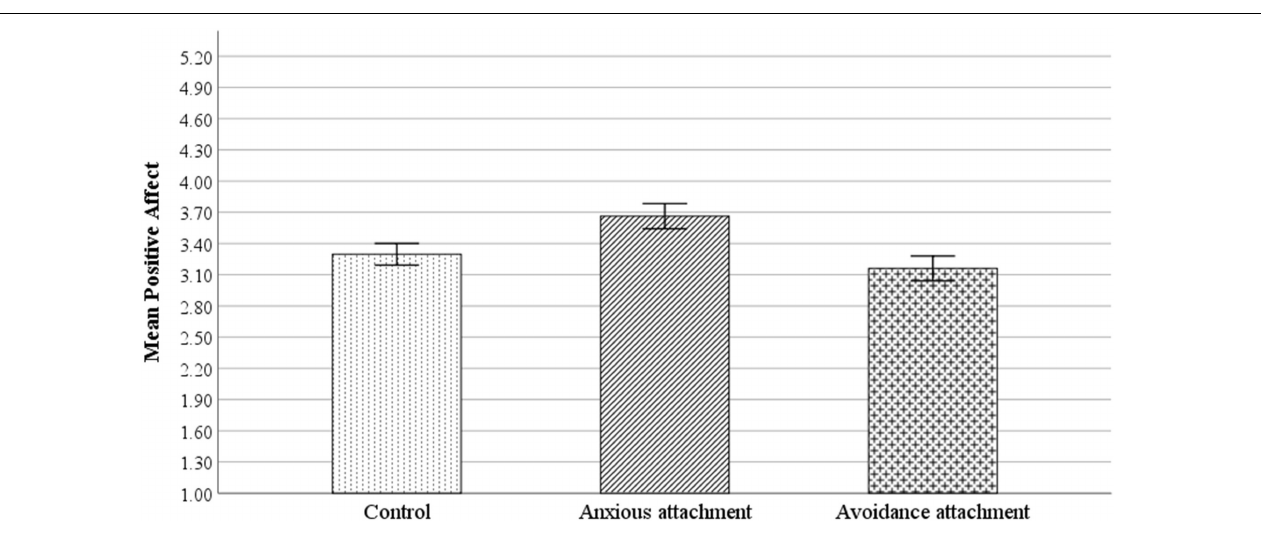
FIGURE 1 | Main effect of anxious attachment on positive emotions compared to control and avoidance ( n = 636).